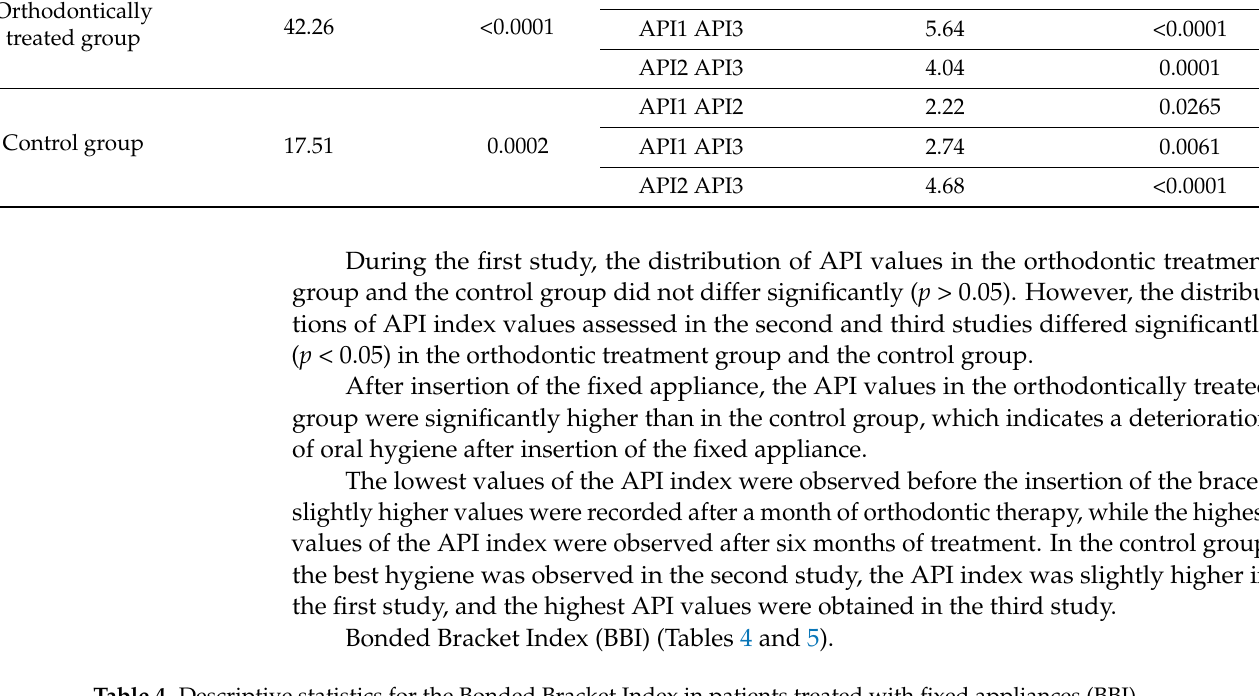
Table 4. Descriptive statistics for the Bonded Bracket Index in patients treated with fixed appliances (BBI). Group Orthodontically treated